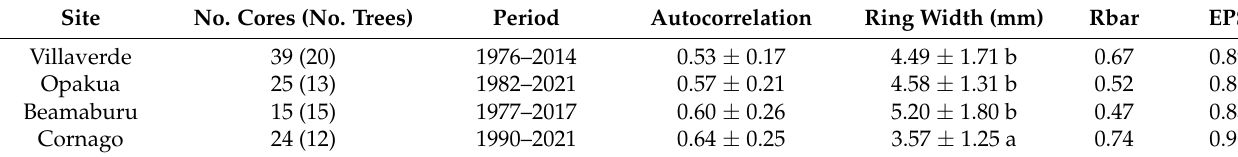
Table 2. Dendroecological statistics for Douglas fir calculated for the common period 1990–2014. Different letters indicate significantly ( p < 0.05) different values between sites according to t -tests. Values are means ± SD.